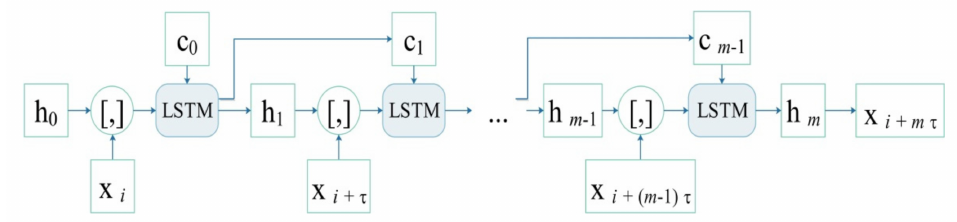
Figure 2. LSTM training